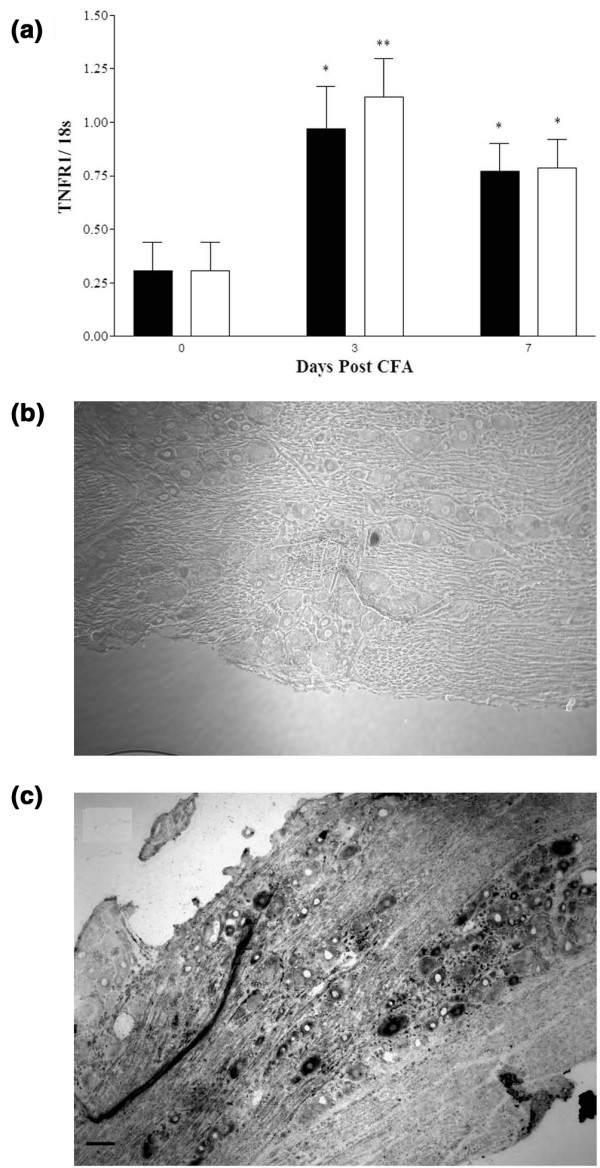
TNFR1 mRNA is increased following inflammation in the dorsal root ganglion (DRG). (a) Real-time RT-PCR showed a threefold increase in mRNA of tumour necrosis receptor type 1 (TNFR1) (expressed as the ratio of TNFR1 mRNA to 18S mRNA) in the DRG following the induction of inflammation by complete Freund's adjuvant (CFA) (n = 4). The increase was bilateral, being observed on both the ipsilateral (black bars) and the contralateral (white bars) DRGs. (b) In situ mRNA hybridisation showed no TNFR1 detection in the naive DRG. (c) In situ hybridisation for TNFR1 in the ipsilateral DRG 7 days after inflammation showed receptor expression in neuronal cells. *P < 0.05, **P < 0.01.